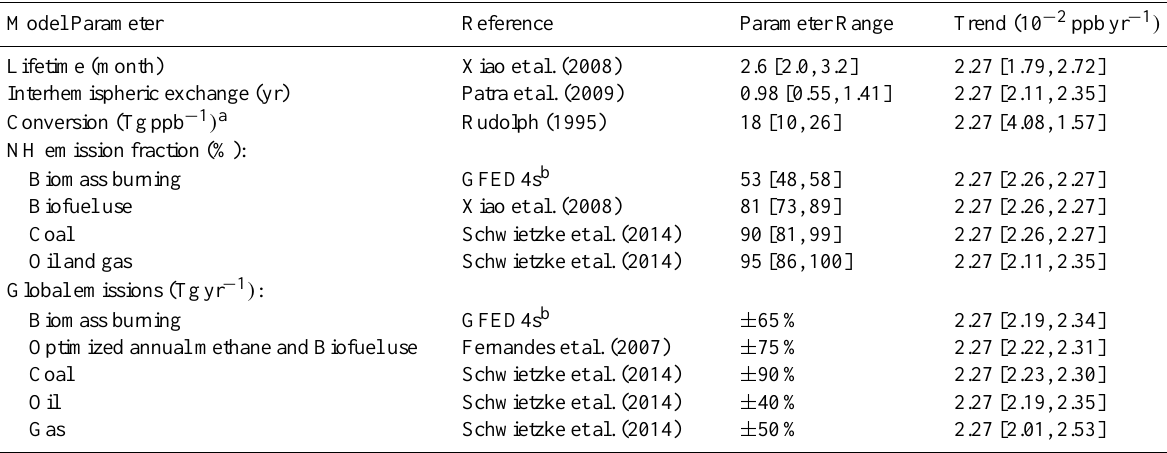
Table B2. Uncertainty of ethane two-box model parameters and implied trend